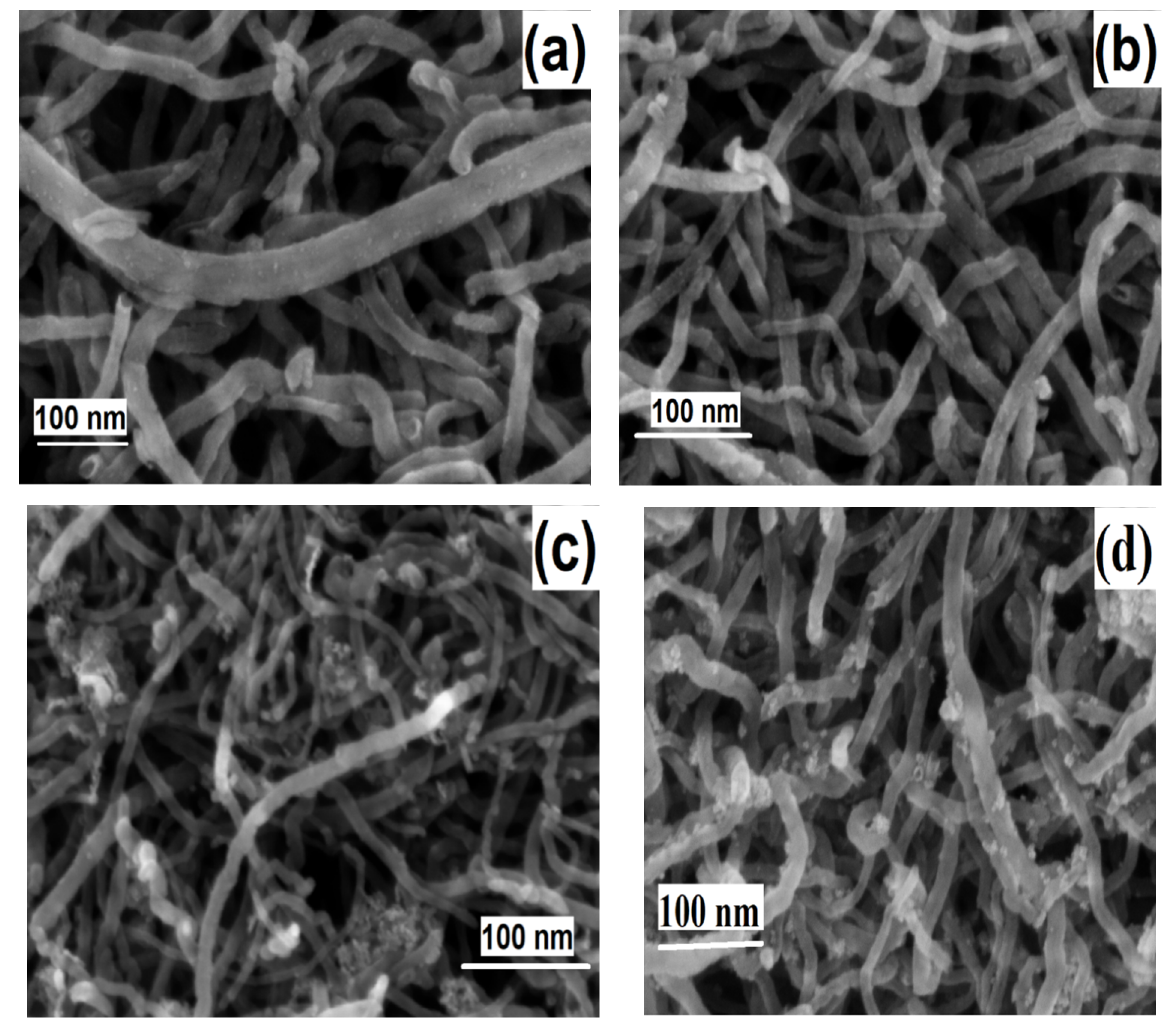
Figure 5. FESEM images of ( a ) 95Co5Mn/CNT, ( b ) 90Co10Mn/CNT, ( c ) 85Co15Mn/CNT, ( d ) 80Co20Mn/CNT catalysts.